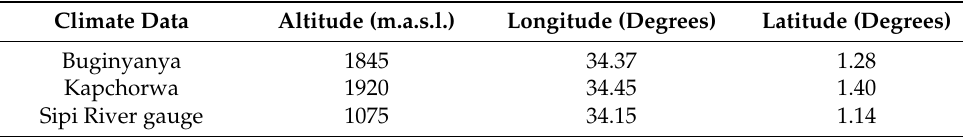
Table 1. The altitudes, longitudes, and latitudes for Buginyanya and Kapchorwa weather stations and river Sipi gauge in the slopes of Mount Elgon.